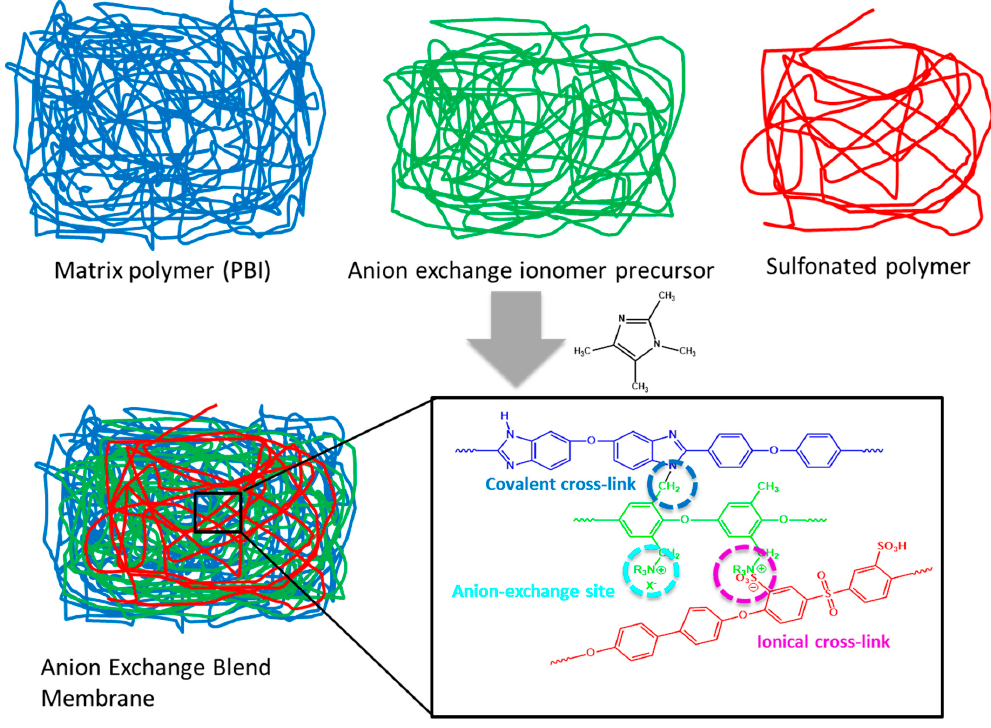
Figure 2. Preparation of anion-exchange blend membranes.